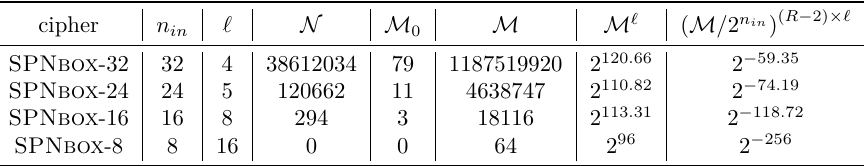
Table 5: Summary of simple hybrid code lifting on SPNbox